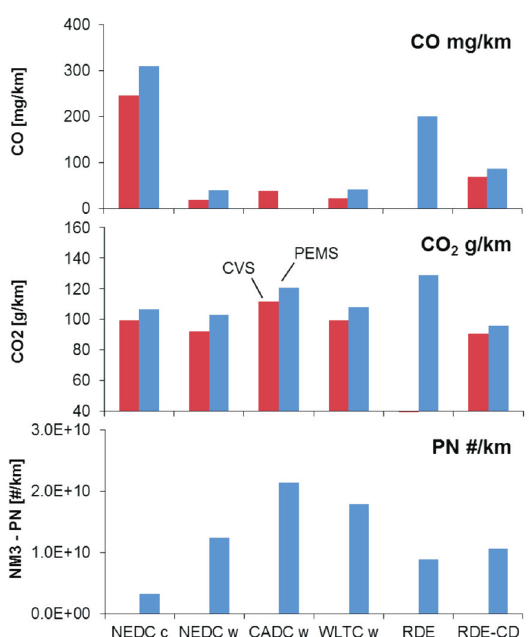
Fig. 12. Emissions of a modern diesel passenger car (Euro 6b) in differ - ent driving cycles and in real driving